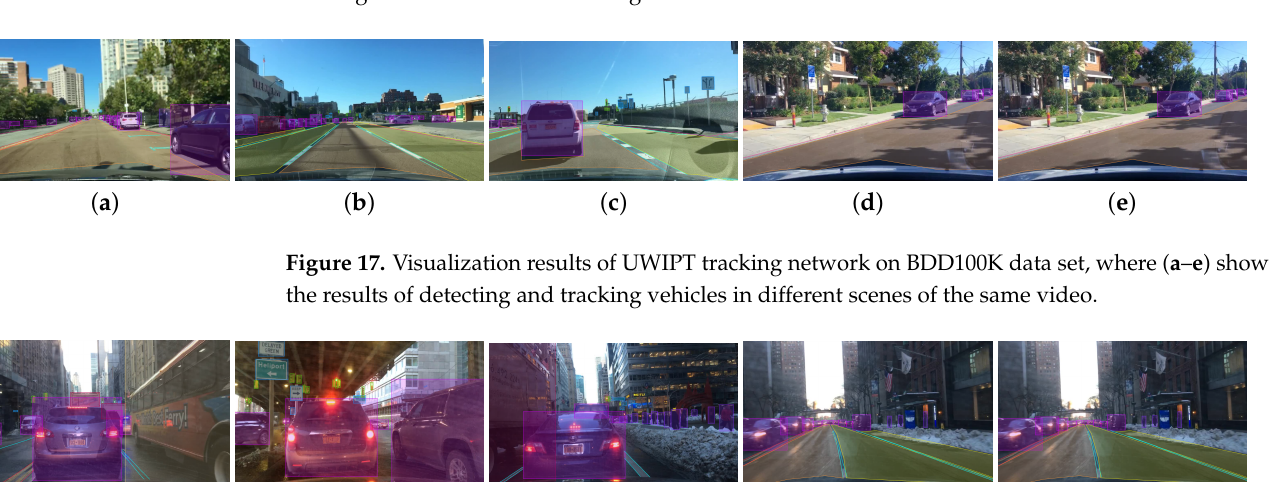
Figure 16. Visualizatio n results of ANU tracking system on BDD100K data set. ( a ) shows the results of vehicle detection and tracking during the day, ( b – e ) show the results of vehicle detection and tracking at different times of the night for the same video.